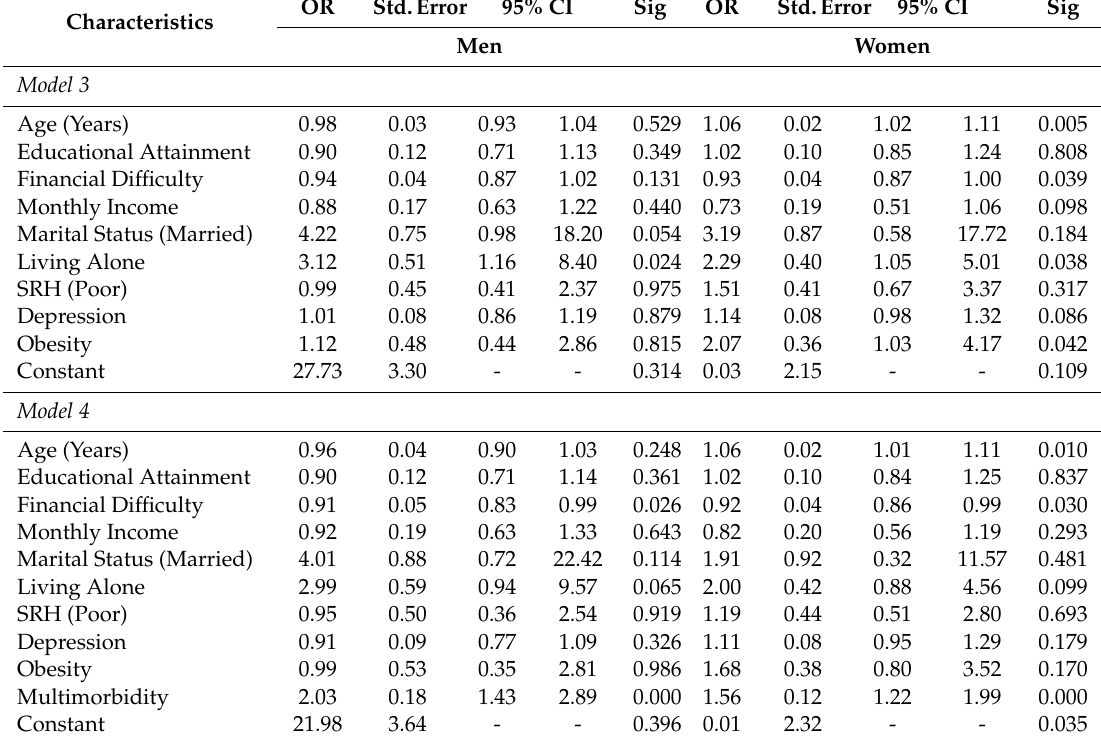
Table 4. Logistic regressions on the associations between obesity, multimorbidity, and polypharmacy in older AA men and older AA